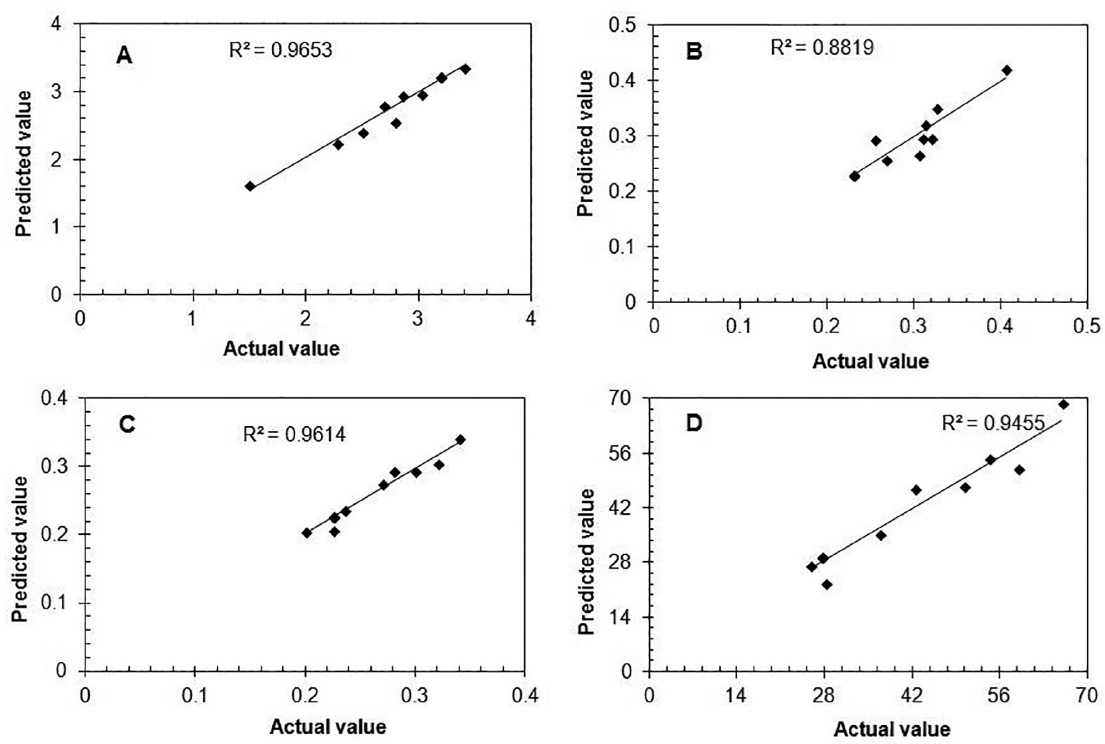
FIGURE 2A-D - Agreement between experimental values and predicted values of antioxidant properties of maize flour. A: Total antioxidant activity, B: Iron chelation activity, C: Reducing power, D: Linoleic acid reduction